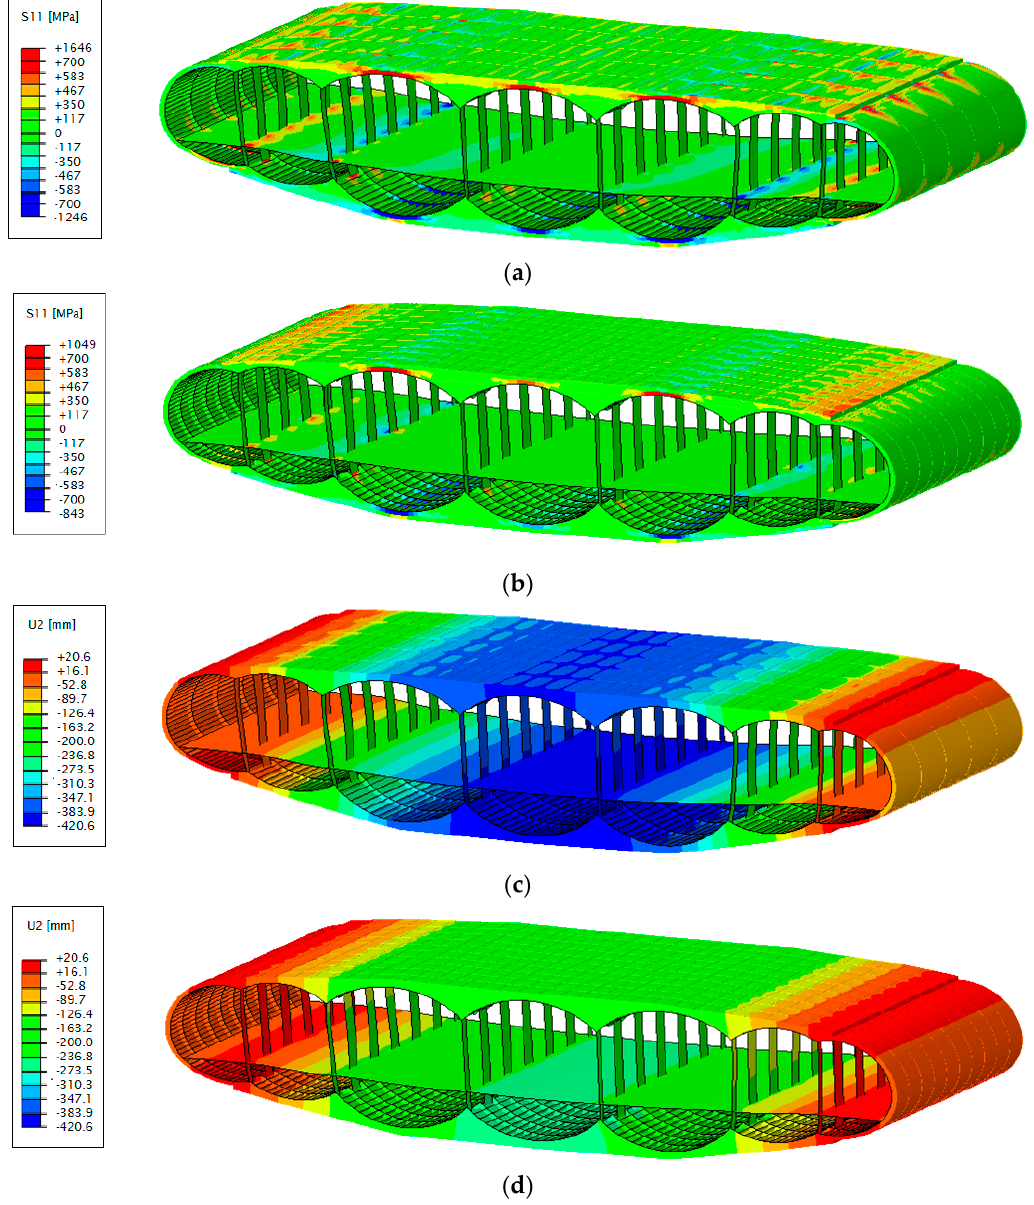
Figure 9. Stress distributions and the deflections for the two different fuselage configurations. ( a , c ) correspond to configuration 1, ( b , d ) correspond to configuration 2.